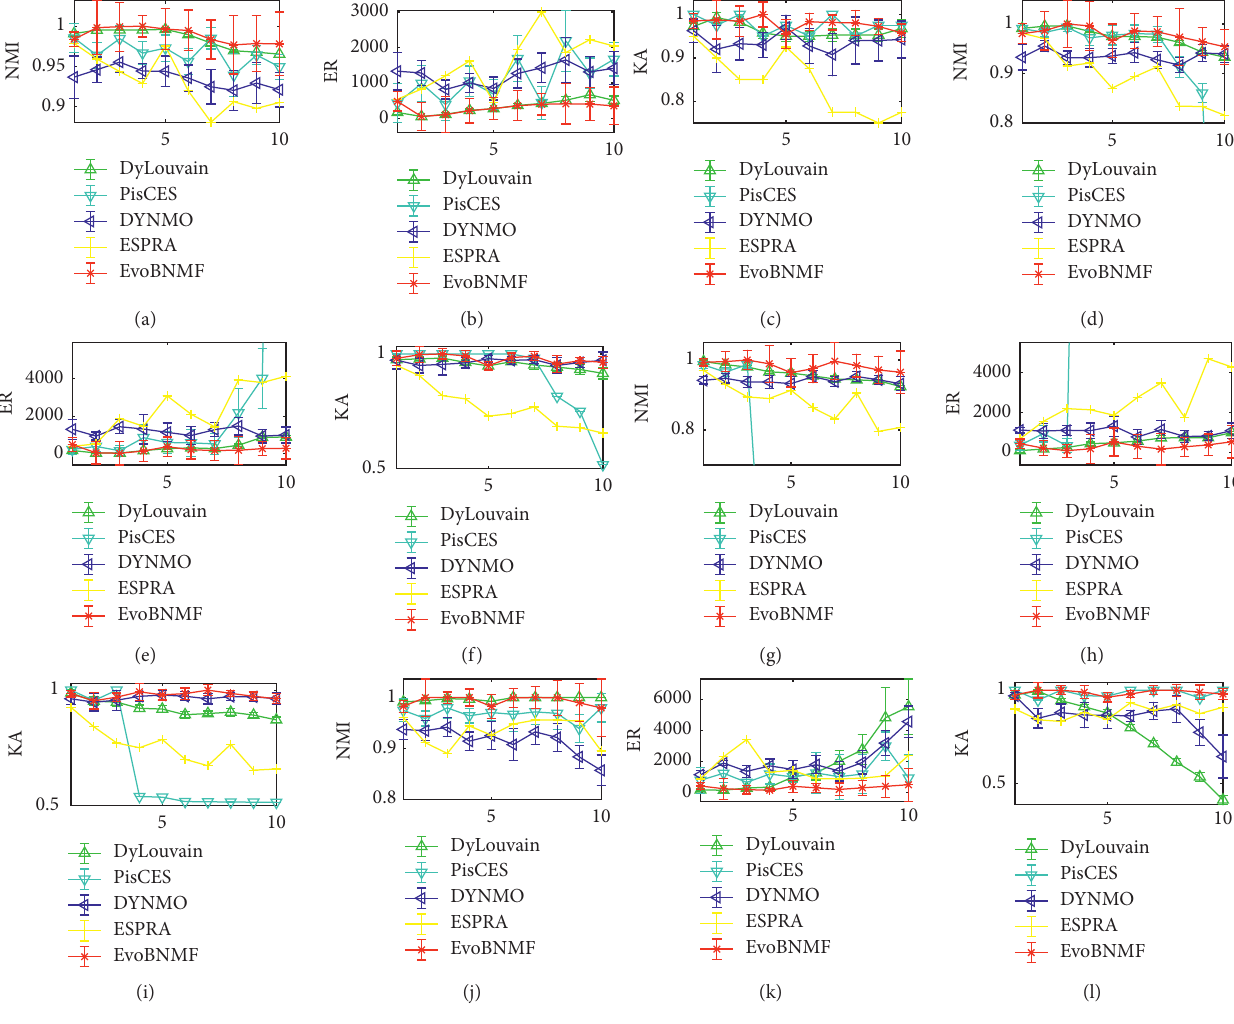
Figure 5: The comparison result of five methods on Net. 5 −